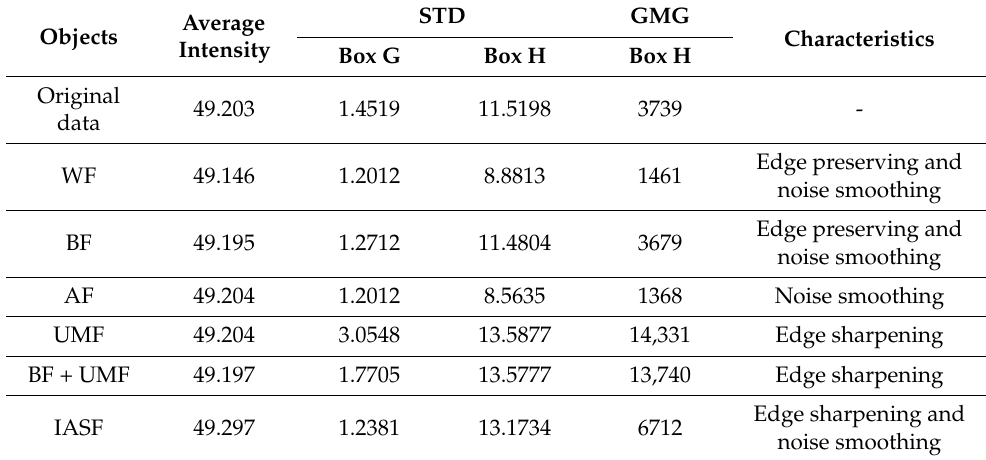
Table 4. The comparison results for image data of target 3.